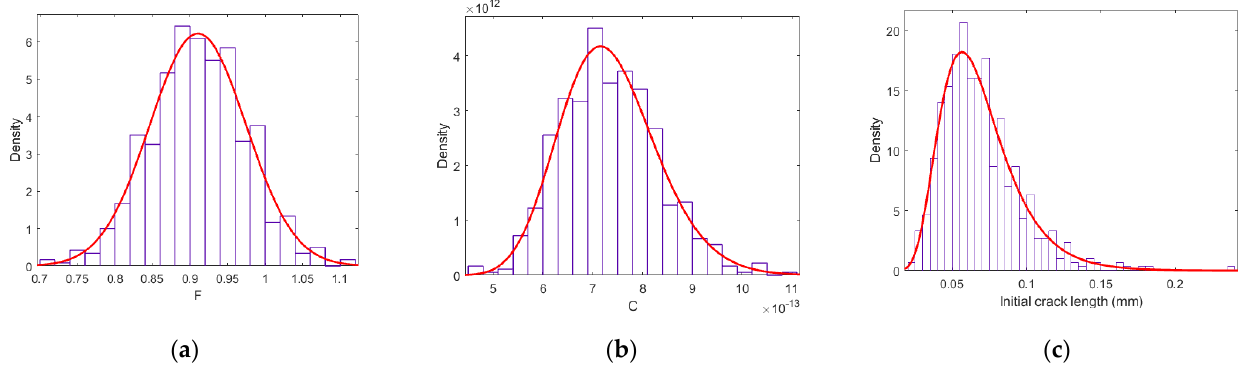
Figure 10. Probability distributions of fracture mechanics parameters: ( a ) model-related parameter F , ( b ) material property-related parameter C , and ( c ) initial crack length at the initial time step.